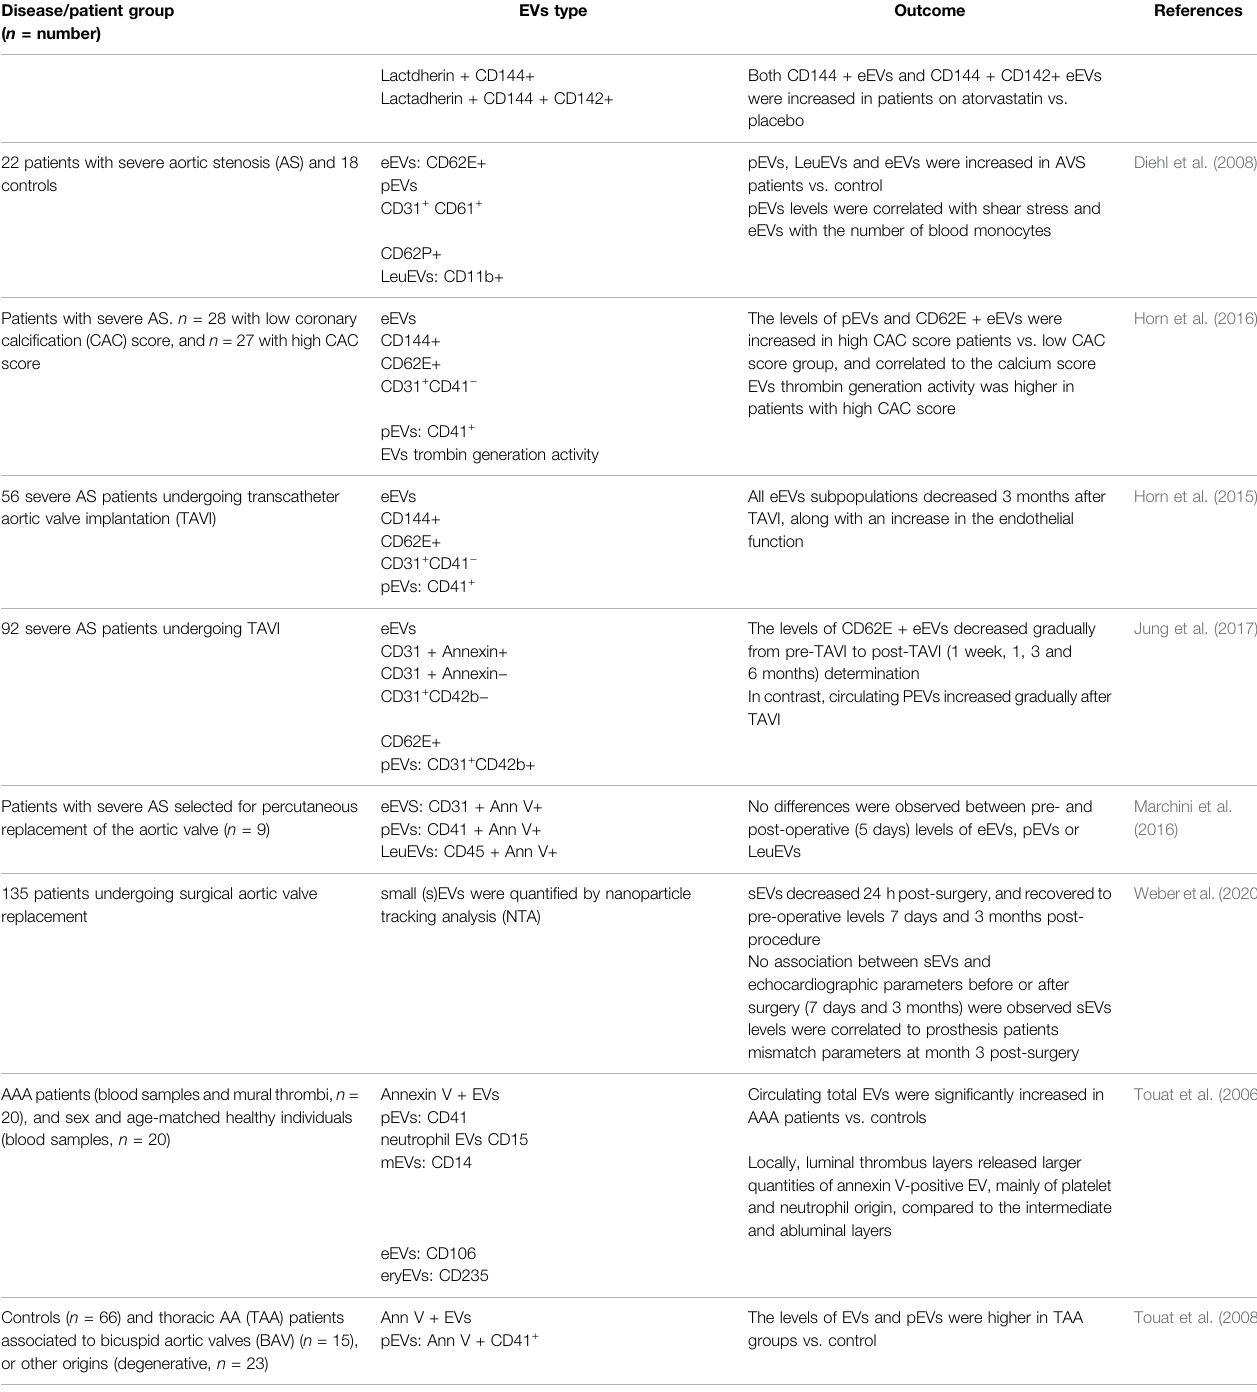
TABLE 1 | ( Continued ) Summary of studies showing a correlation between the levels of total or speci fi c cell type EVs subpopulations, measured by fl ow cytometry, in circulation (plasma) and cardiovascular